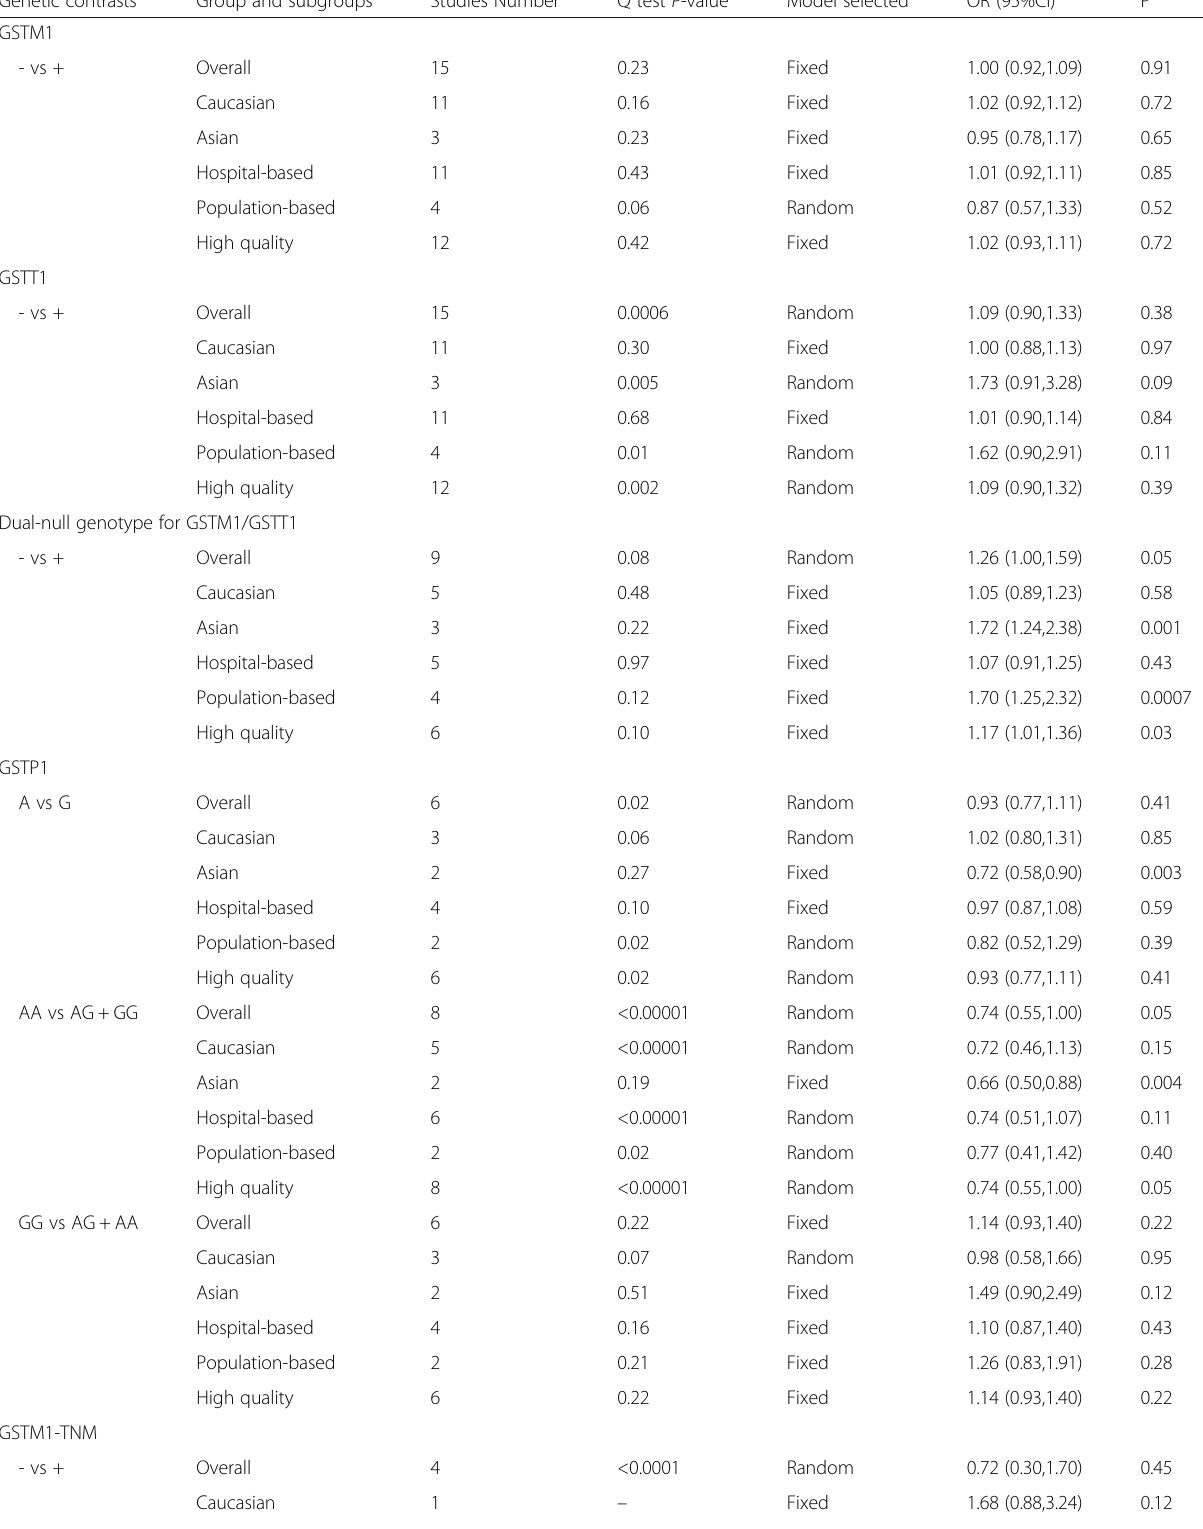
Table 4 Meta-analysis of the association of GSTM1- and GSTT1-null genotypes and GSTP1 with RCC risk and the relationship between GSTM1, GSTT1 and clinical TNM stages of RCC Genetic